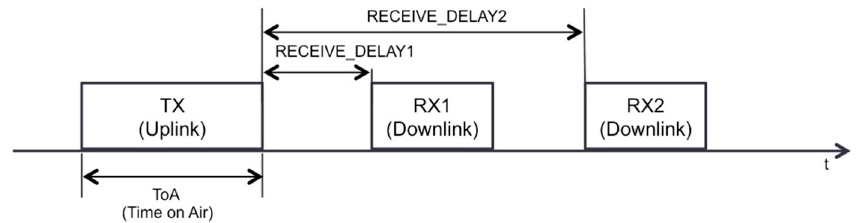
Figure 2. Basic transmission scheduling in LoRaWAN Class A functionality.